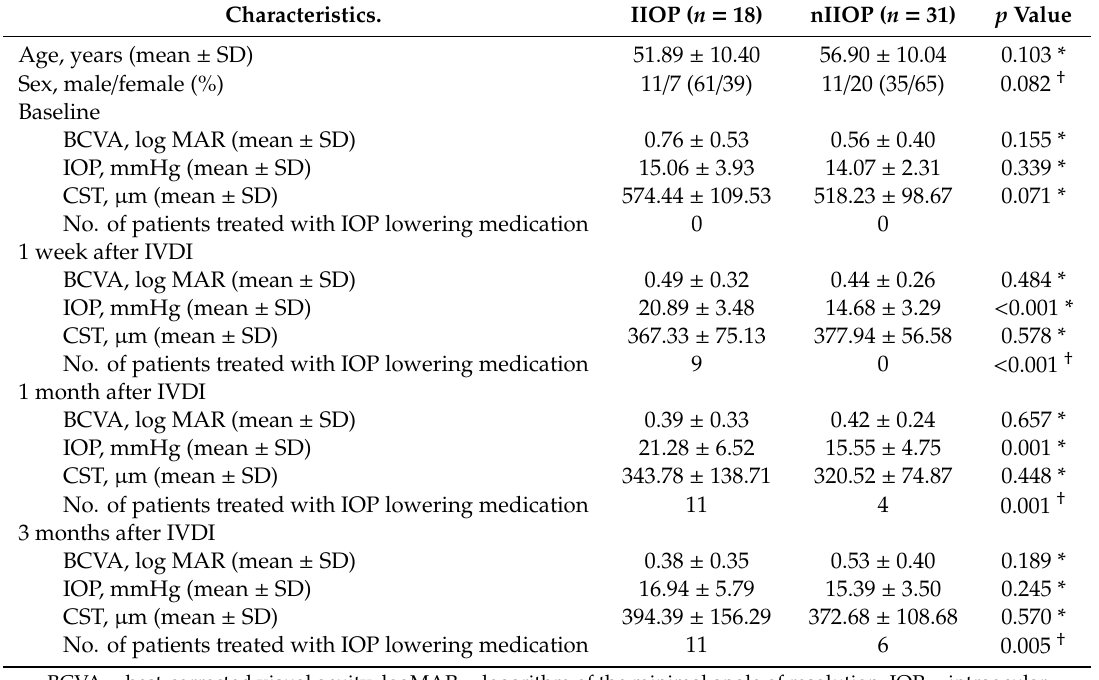
Table 2. Comparisons of BCVA, IOP and CST between the IIOP and nIIOP groups over 3 months.